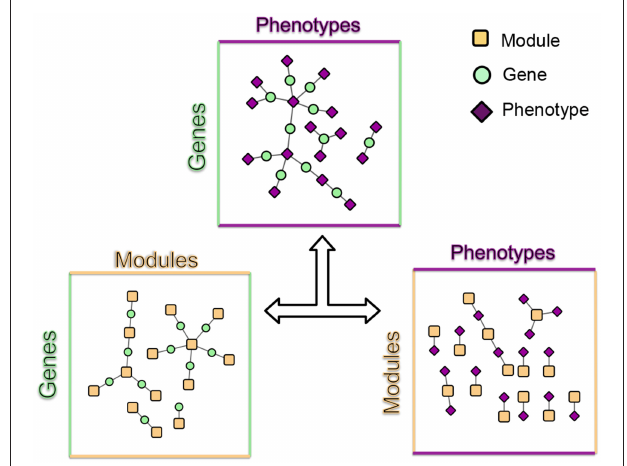
FIGURE 6 | MPA decomposition. The gene-phenotype matrix is decomposed into two matrices, a gene-module ( GM ) matrix and a module-phenotype ( MP ) matrix ( Supplementary Texts S3 , S4 , Supplementary Figure 1 ). The GM matrix represents genes in powerset space. Association modules (elements of the powerset of phenotypes) form the basic units of MPAs and are considered latent variables. Signature clustering is performed on genes in module space ( GM matrix).